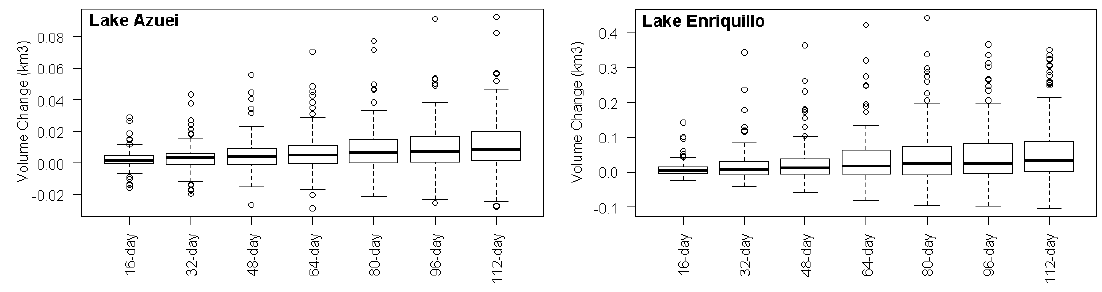
Figure 3. Datasets of volume change